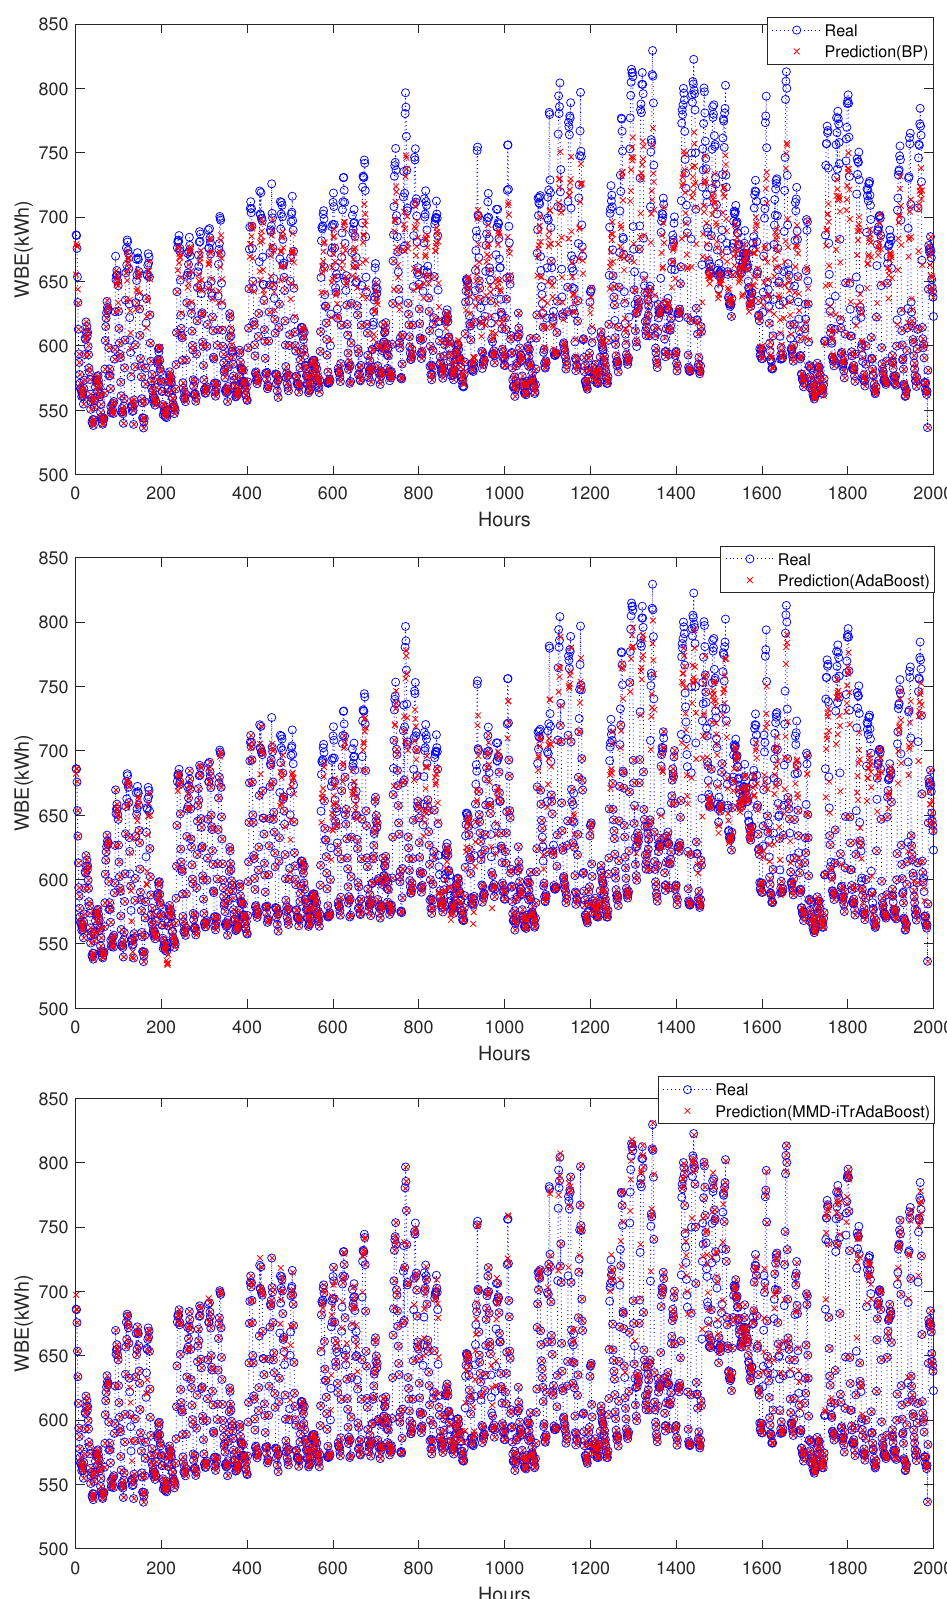
Figure 8. Real and predicted electricity loads using three predictive models, ratio of training data from target domain: 30%, 2000 h